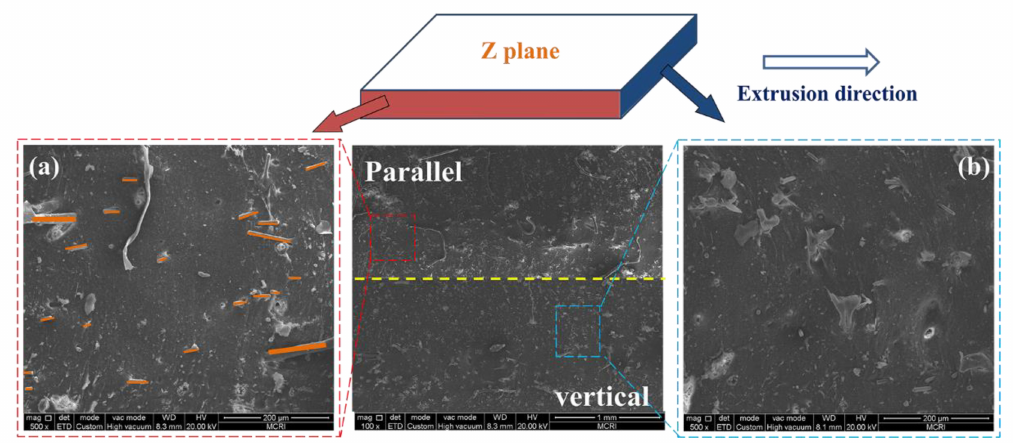
Figure 5. SEM images of the section of (AM/HM) 20 : parallel to the extrusion direction ( a ); perpendic- ular to the extrusion direction ( b